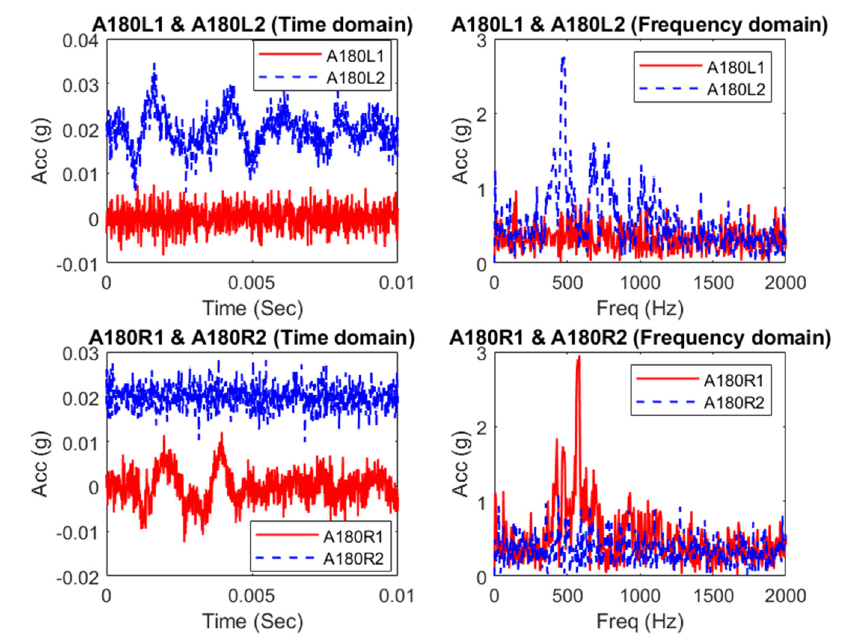
Figure 12. Captured time domain acceleration data and their frequency spectra at 180 ◦